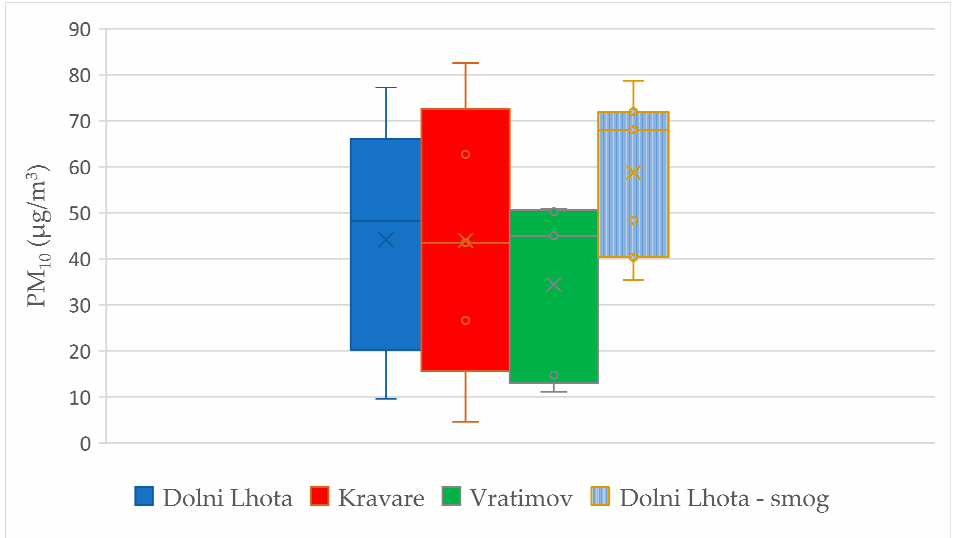
Figure 5. Boxplot-type comparison of daily average PM 10 concentrations on selected days during the heating season in 2018.